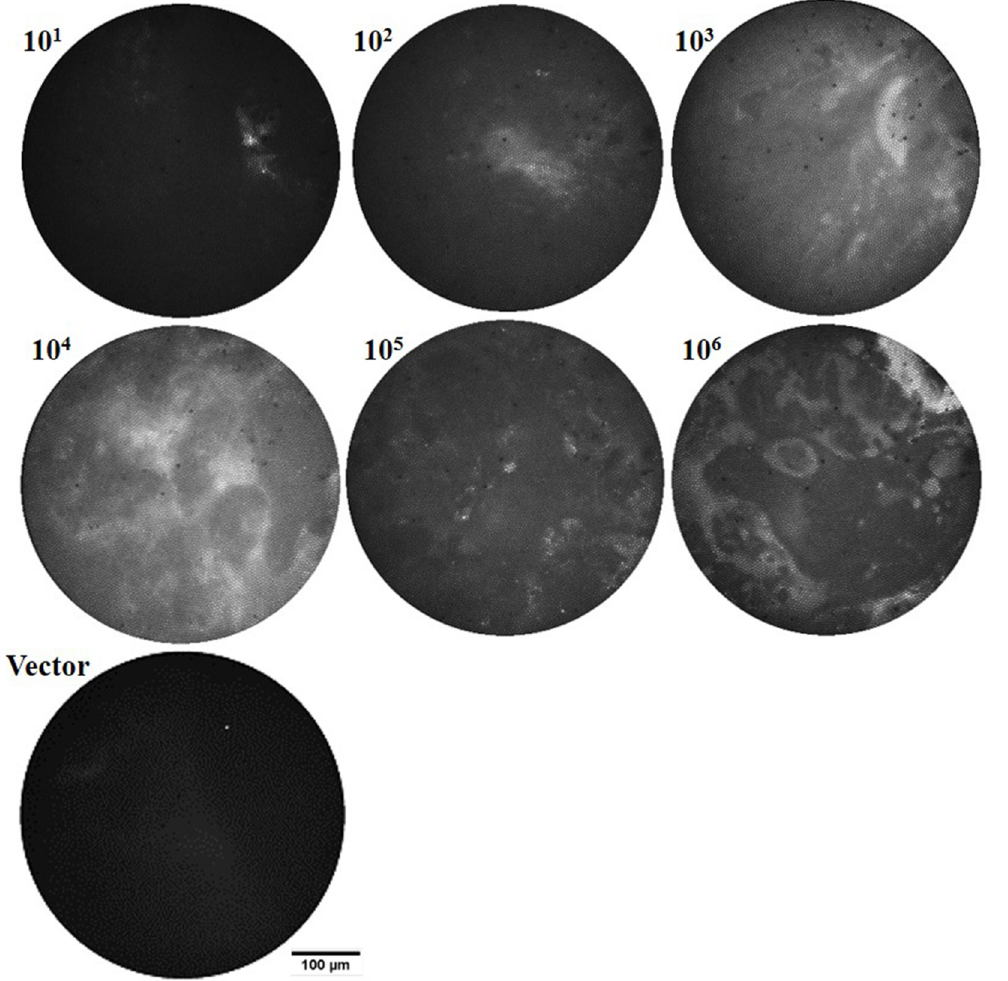
Fig 5. In vivo microendoscope images provide feedback for positioning the intravital excitation source and can allow a qualitative evaluation of bacterial loads in the lungs. Representative in vivo fiber microendoscopy images of infected mice lungs, 24 hr post-infection with 10 1 − 10 6 colony forming units (CFU) BCG17 (tdTomato expressing BCG strain) and 10 5 CFU BCG39 (BCG containing the same vector that does not express tdTomato (Vector)).